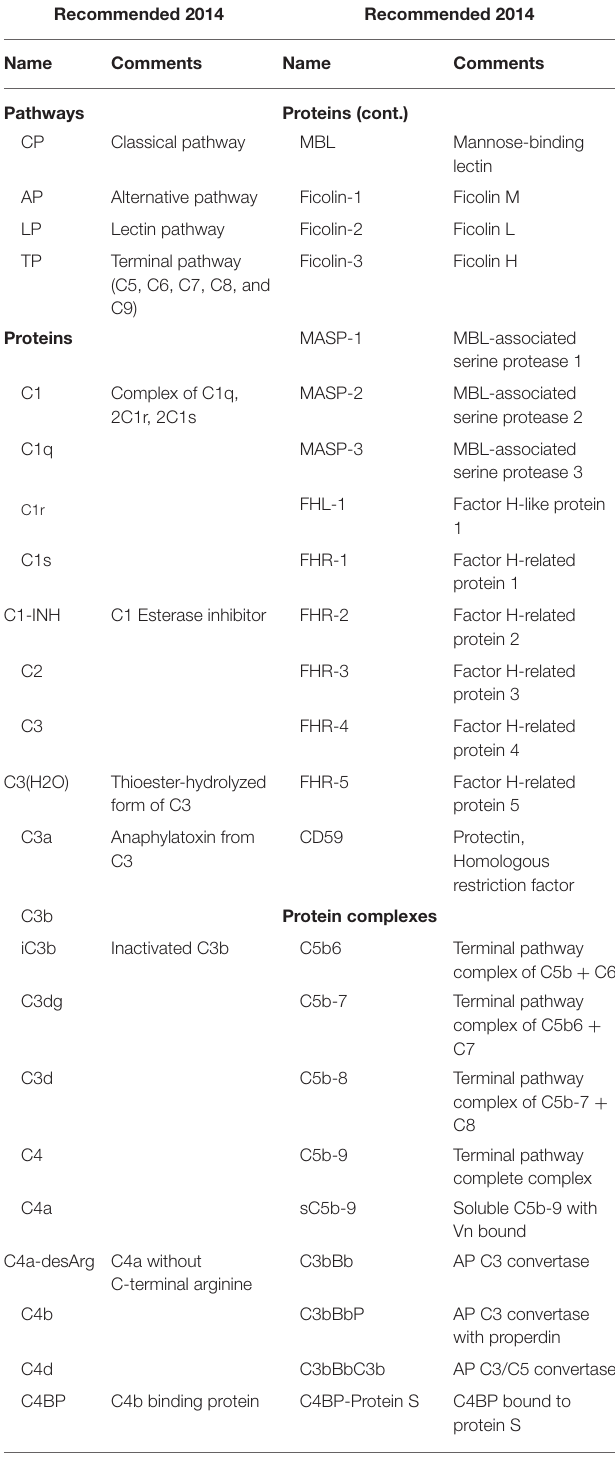
TABLE 1 | (Top) Complement nomenclature as per International Complement Society (ICS) Complement Nomenclature Committee, and ICS and European Complement Network (ECN) boards recommendation from 2014 [reproduced with permission